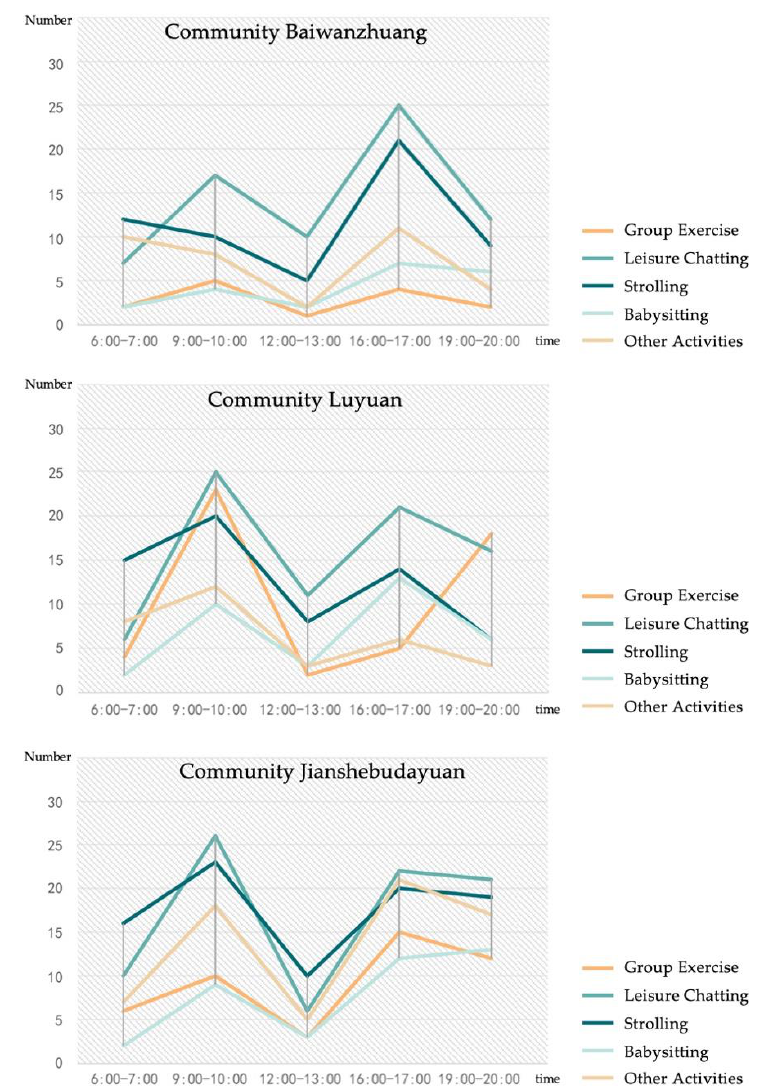
Figure 4. Time and types of social interaction among elderly women.